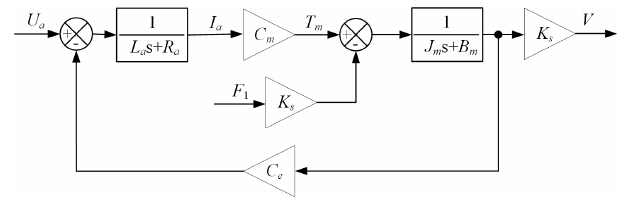
Figure 11. Block diagram of drive unit